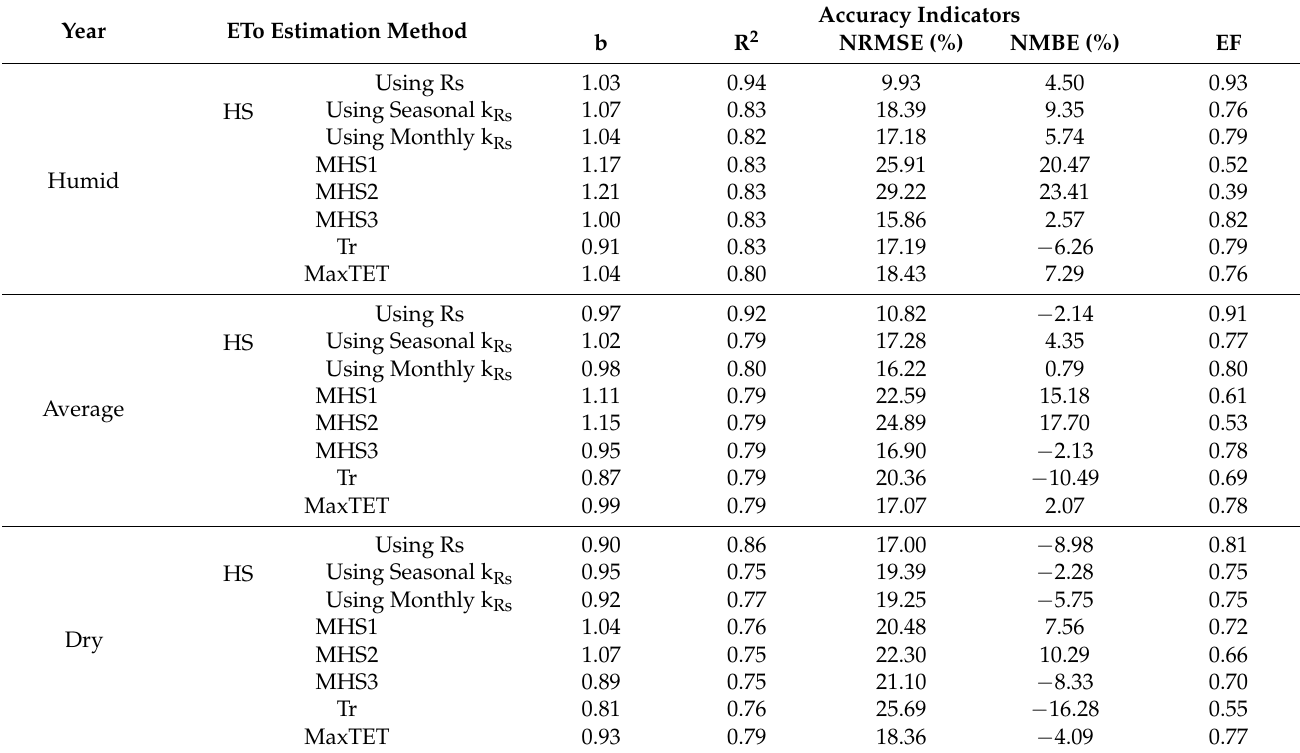
Table 4. Accuracy indicators for the relationship between daily ETo estimated by the Penman–Monteith equation, by the temperature-based equations for Beja and for three different years–humid, average and